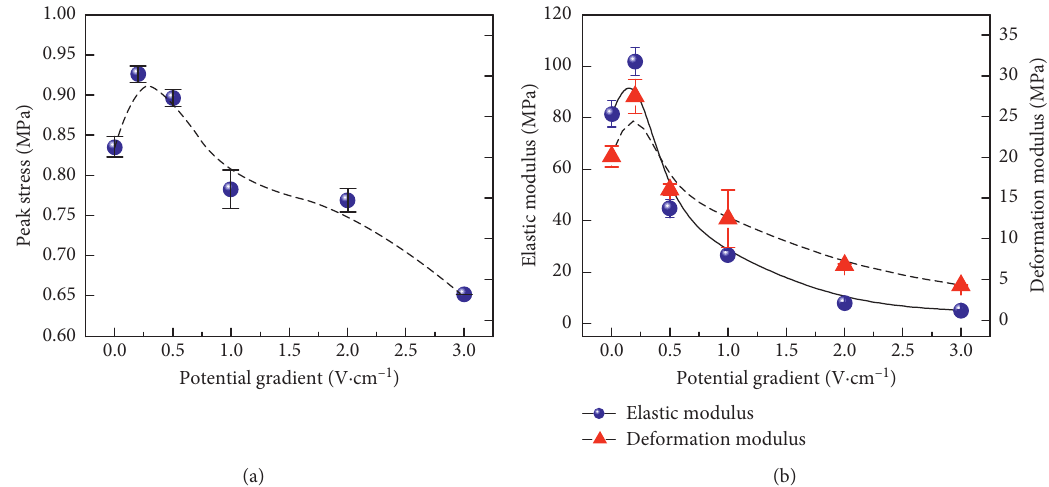
Figure 7: The change in (a) peak strength and (b) elastic modulus and deformation modulus of samples after electrochemical modification with different potential